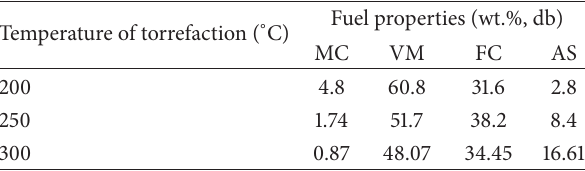
Table 2: Proximate analysis of sugarcane bagasse at different torrefaction